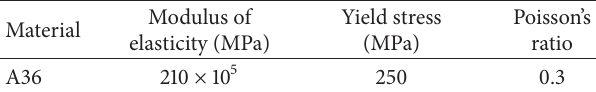
Table 3: Material properties used in